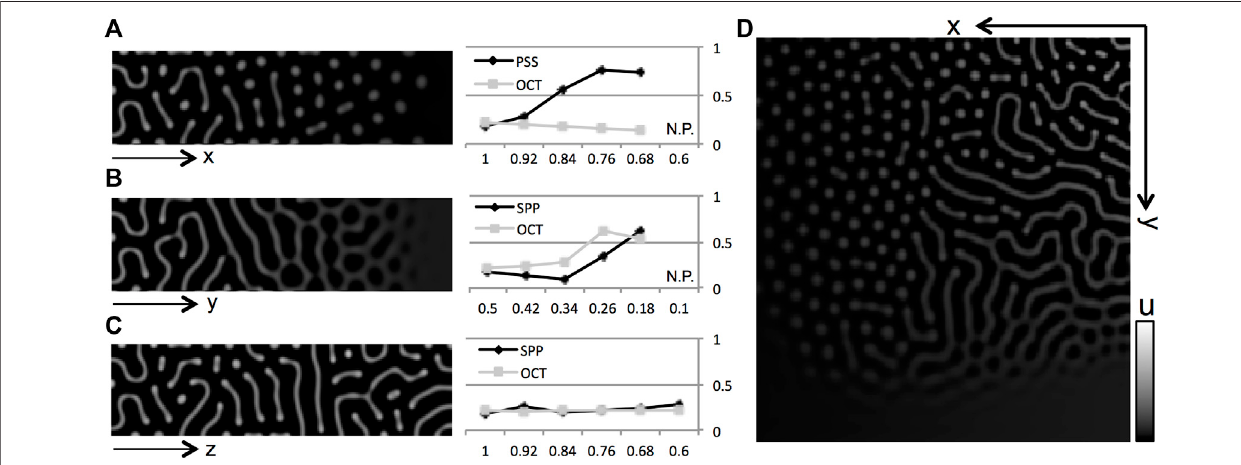
FIGURE 5 | Numerical results ofgate effects by nonlinear model. (A – D) Numerical results obtained from a model with nonlinear reaction terms. Pattern shifts were observed when the effects of gate defects on both cells were changed. (A) U defect, (B) V defect, and (C) short-range defects, and between the cells, became larger alongthe x − , y − ,and z (or x , y )-axes,respectively.Patternquanti fi cationbyPSSandOCTareshownontheright.Then,theshort-rangeinhibitionsweredecreasedalong both axes, spontaneously. All results are shown as density plots of u .